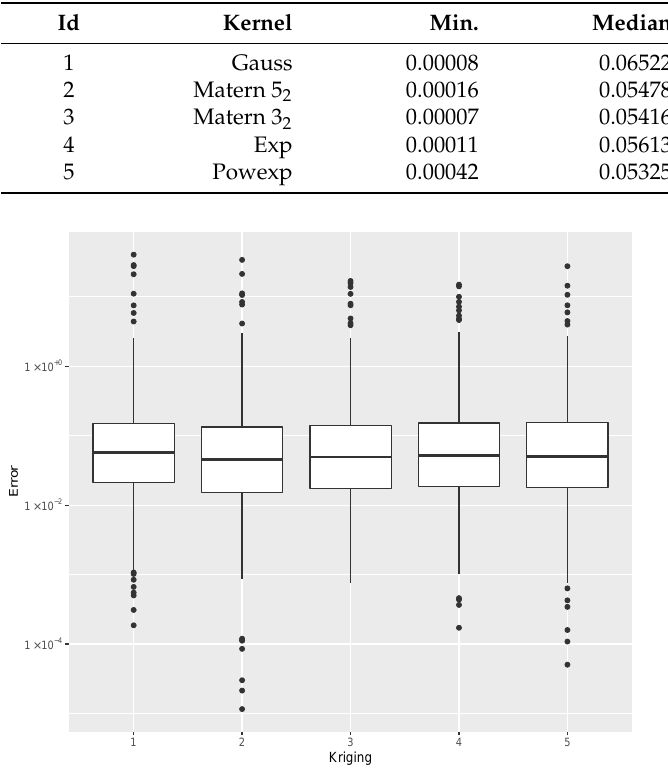
Figure 10. Error dispersion of the P critical estimate using distinct Kriging kernel